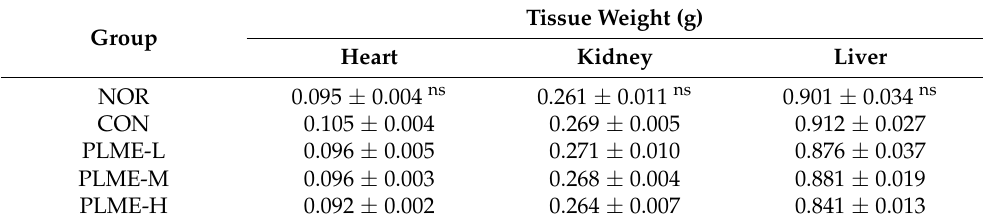
Results are expressed as mean ± standard error ( n = 8). ns, not statistically significant among all groups ( p > 0.05). NOR, normal group administered tap water; CON, medium control group administered only culture medium (250 mg/kg/day); PLME, P. linteus postbiotic materials; PLME-L, PLME-M, and PLME-H, sample groups administered postbiotics prepared from P. linteus mycelial submerged culture at doses of 250, 500, and 1000 mg/kg body weight (bw)/day, respectively.